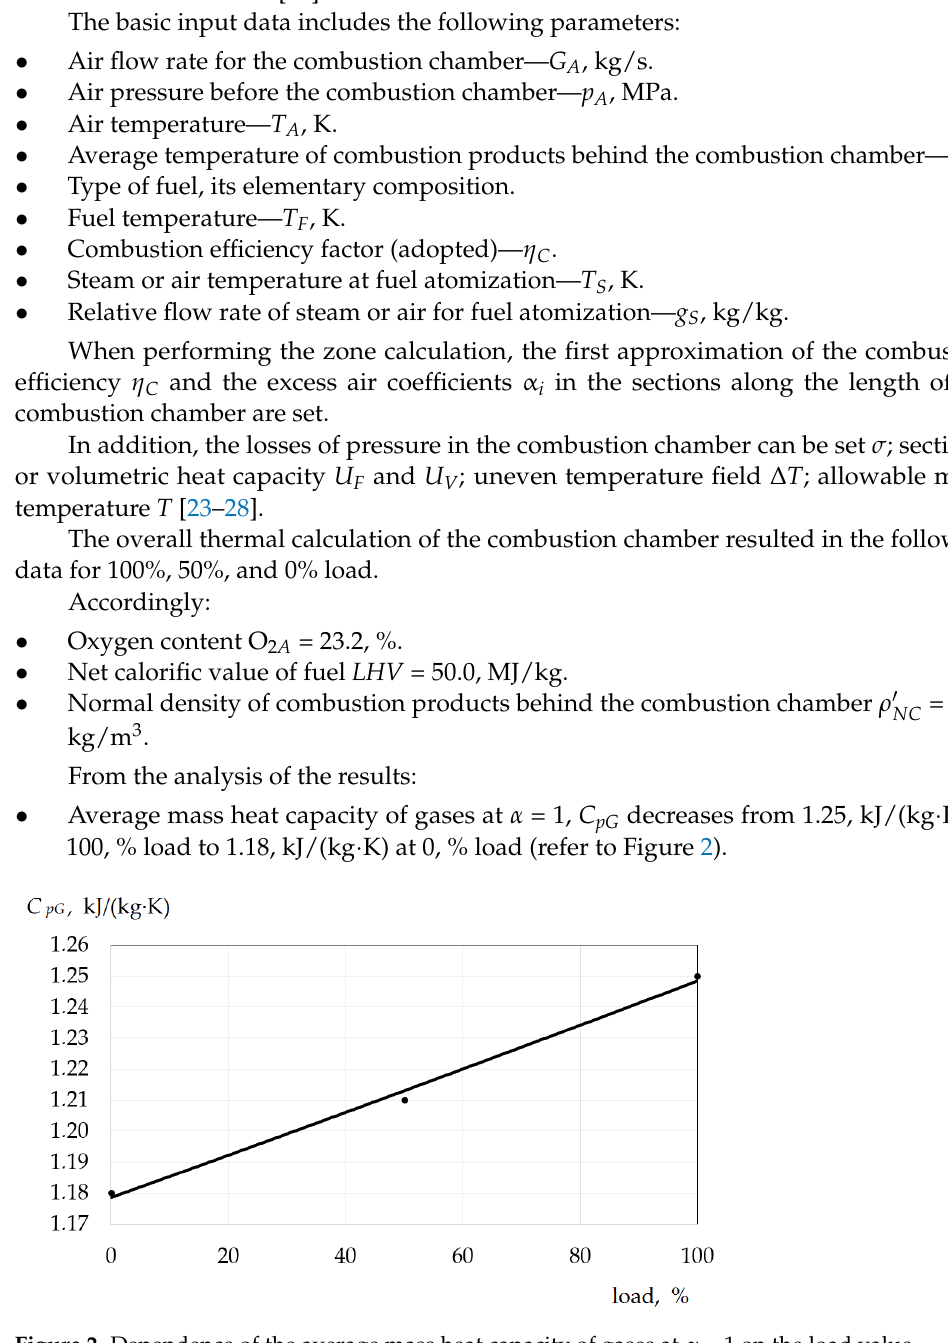
Figure 2. Dependence of the average mass heat capacity of gases at α = 1 on the load value.